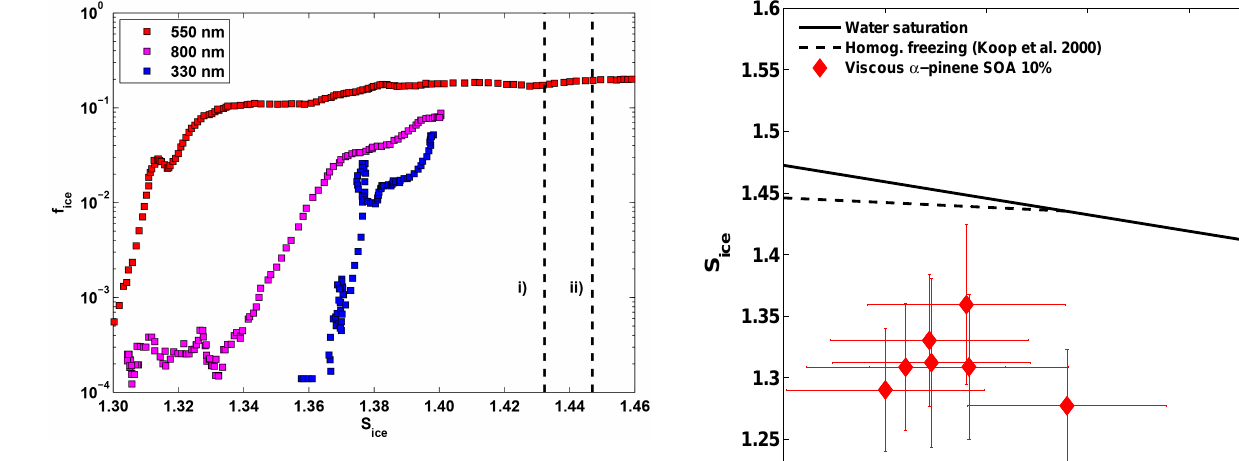
Figure 4. Examples of frozen fractions of viscous α -pinene SOA obtained with SPIN as a function of the ice saturation ratio S ice . The blue squares correspond to seed aerosol of 330nm, formed at − 38 ◦ C, the red squares are the 550nm particles, formed at − 20 ◦ C, and the magenta squares are 800nm particles, formed at − 10 ◦ C. At the time of ice formation, the aerosol sample temperature inside SPIN was kept at approximately − 38.5 ◦ C for 330nm particles; for 550nm particles the temperature was at − 37.2 ◦ C and for 800nm particles at − 38.2 ◦ C. The black dashed vertical lines correspond to water saturation at (i) − 37 ◦ C and (ii) − 38 ◦ C. Ice activation thresholds (1, 5, 10%) were determined from similar ice activation graphs.